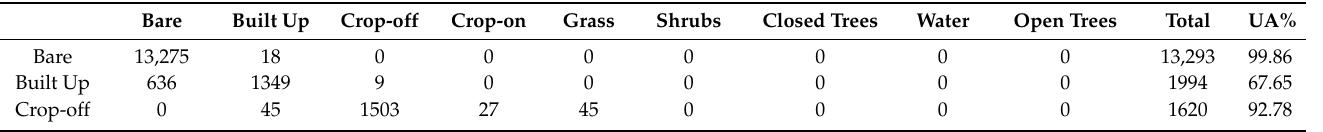
Table 2. Confusion classification matrix for the landscape classes in the Northern Kenya/Southern Ethiopia study region mapped using the Landsat 7 ETM+ composite images for 2001, and using random forest as a